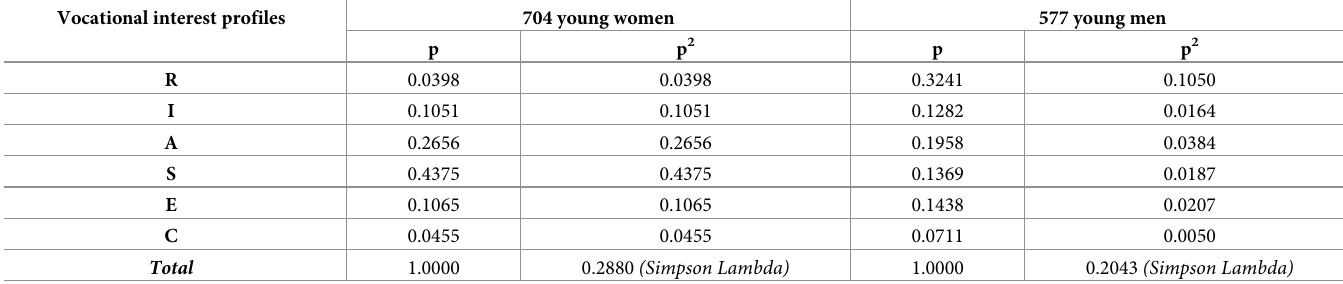
Table 8a. Six one-dimensional interest types.